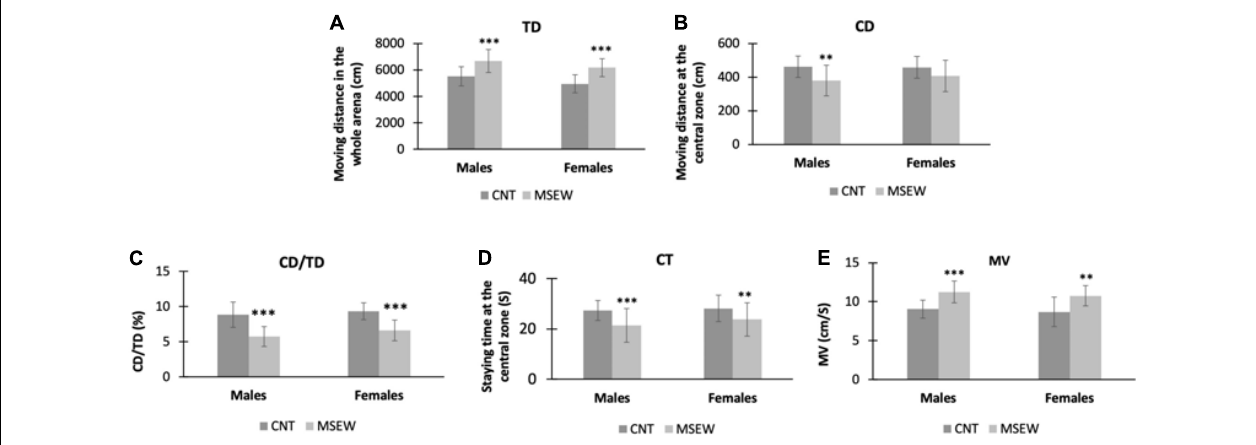
FIGURE 3 | Performance of rats in the open field test. (A) Moving distances of CNT and MSEW rats on the whole arena of open field. (B) Moving distances of CNT and MSEW rats at the central zone of open field. (C) The values of CD/TD of CNT and MSEW rats. (D) The staying time of rats at the central zone of open field. (E) The moving velocities of rats in the open field. Data were expressed as mean ± SD. n = 15/group. ** p < 0.01, *** p < 0.001, MSEW vs Control.